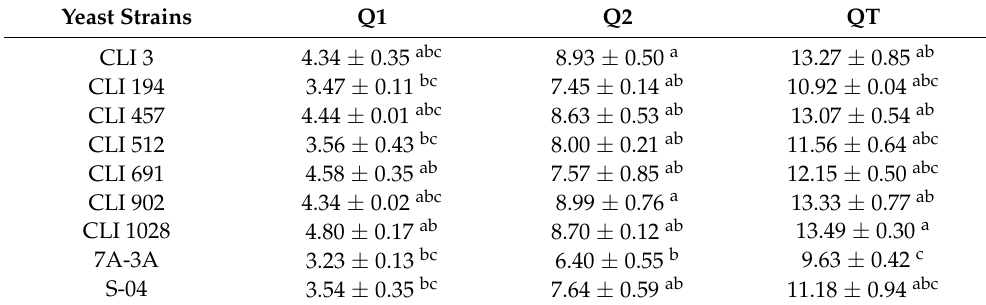
Table 7. Antioxidant capacity of beers fermented sequentially and of the S-04 control strain. Yeast